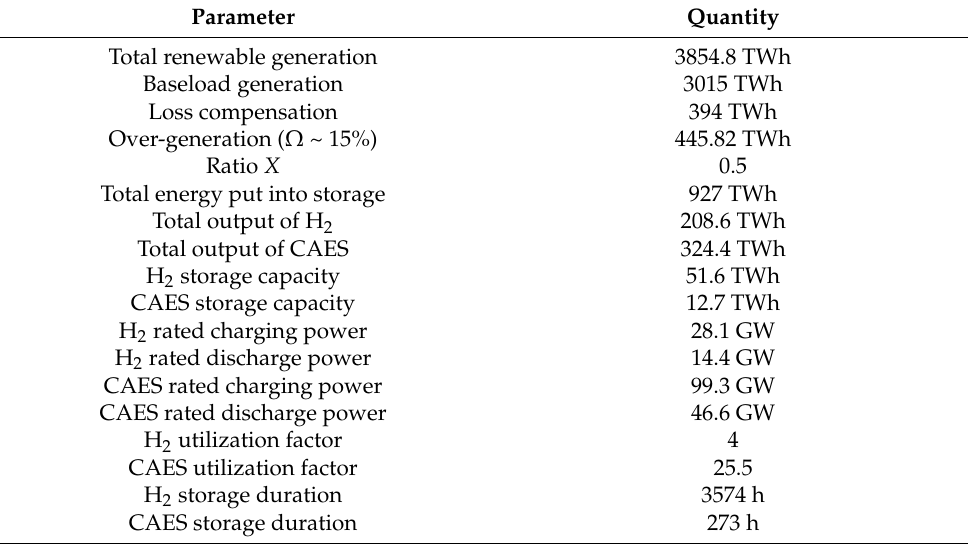
Table 2. Technical parameters of the optimum system configuration, achieved with a ratio X = 0.5.